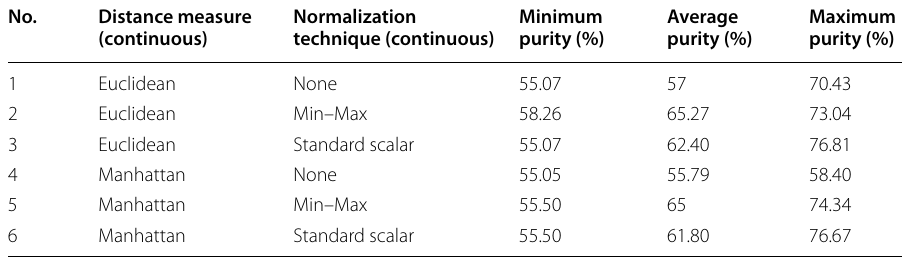
Table 8 Performance of FCMD-MD on Australian Credit dataset